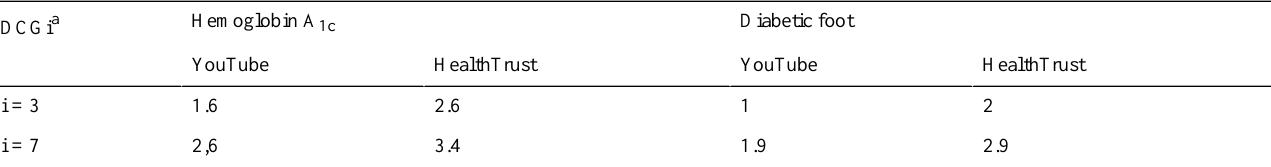
Table 4. Discounted cumulative gain (DCG) for videos evaluated by professionals retrieved by HealthTrust and YouTube